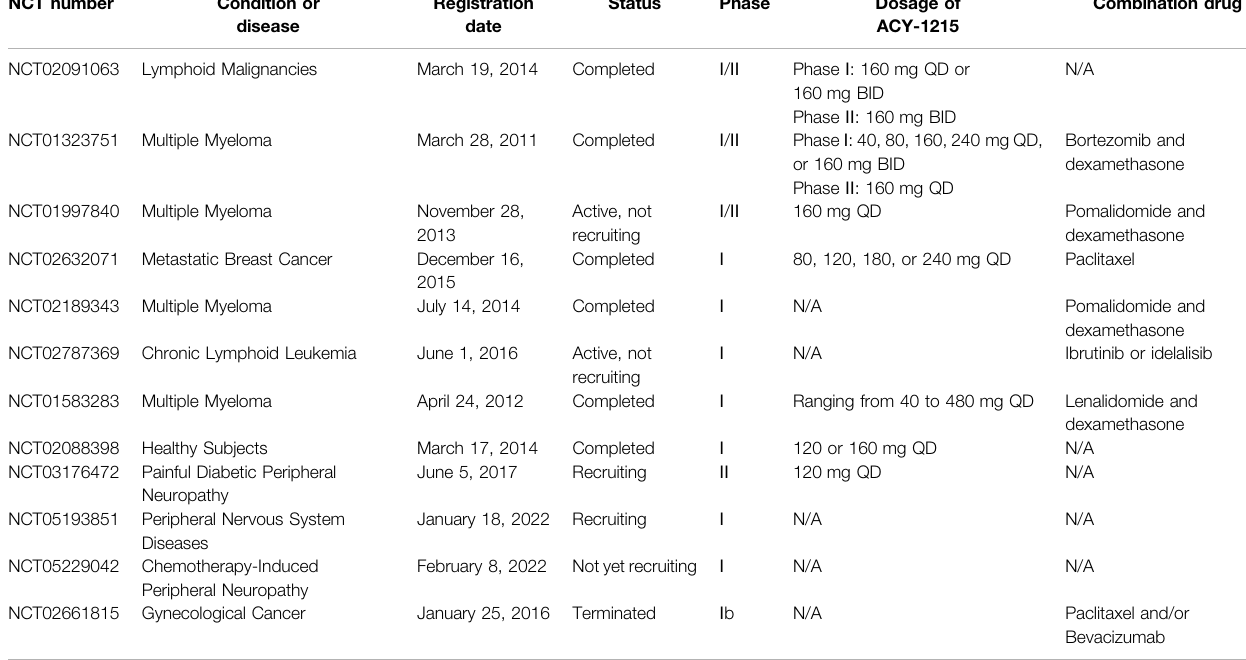
TABLE 1 | ACY-1215 in different phases of clinical